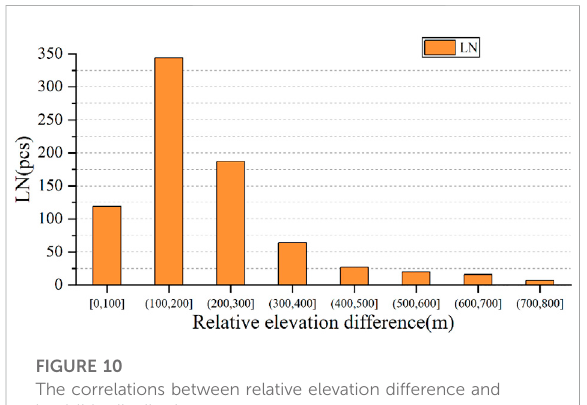
FIGURE 10 The correlations between relative elevation difference and landslide